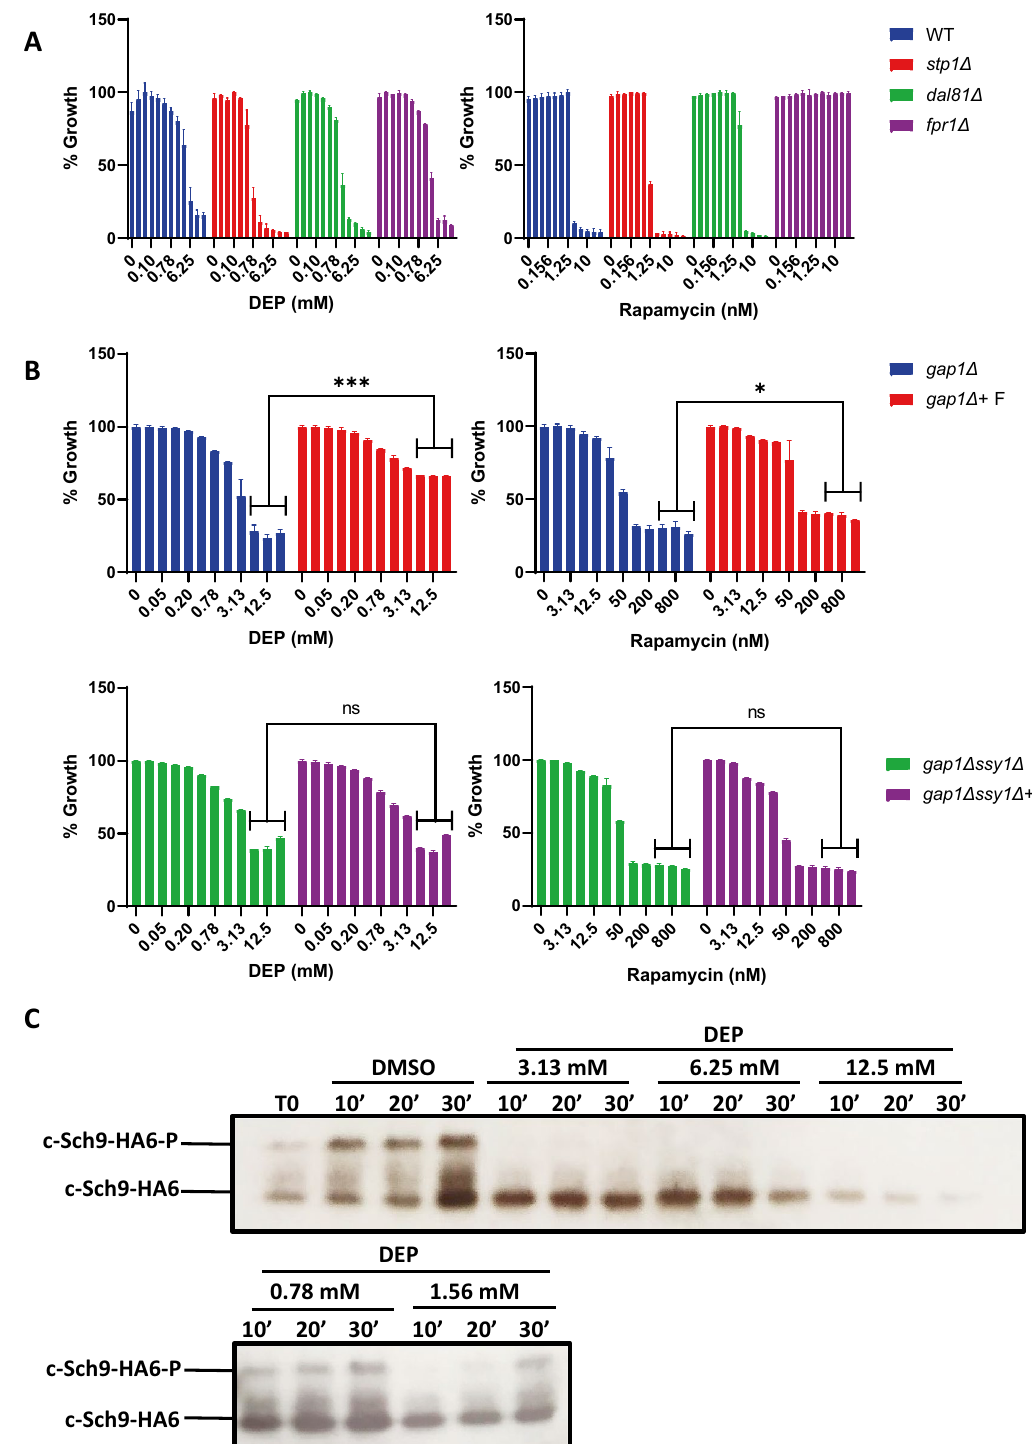
Figure 9. Treatment of yeast cells with DEP reduces TORC1 activity. ( A ) Comparison of normalized growth in wild type, stp1Δ , dal81Δ and fpr1Δ (S288C background) exposed to two-fold serial dilutions of DEP (maximal concentration at 25 mM) and Rapamycin (maximal concentration at 40 nM). ( B ) Normalized growth of gap1Δ and gap1Δ ssy1Δ cells (Σ1278b background) in minimal urea medium with and without phenylalanine (F) (5 mM) and exposed to two-fold serial dilutions of DEP (maximal concentration at 25 mM) and Rapamycin (maximal concentration at 1600 nM). Error bars represent mean ± SD from technical duplicates (One-tailed paired t -test, * P ≤ 0.05, ** P < 0.01, *** P < 0.001). ( C ) Western blot of wild type yeast cells (Σ1278b background) treated with DMSO or DEP (0.78, 1.56, 3.13, 6.25 or 12.5 mM) for 10, 20 and 30 min. T0: Cycling cells. Unprocessed images of the two westerns are presented in Fig.